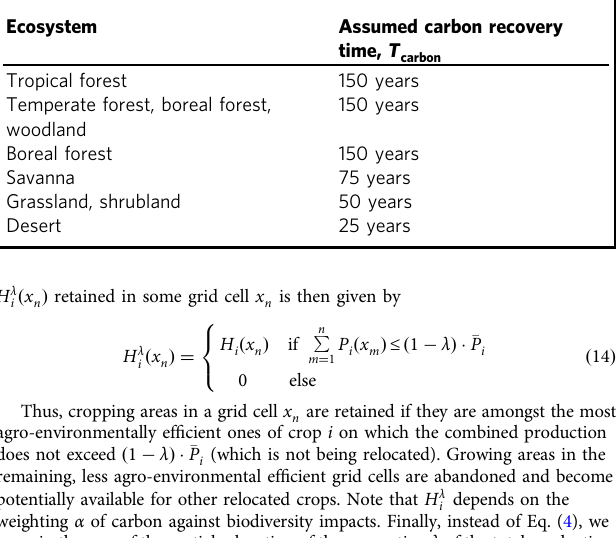
Table 3 Assumed times required for carbon stocks on abandoned cropland to reach pre-disturbance